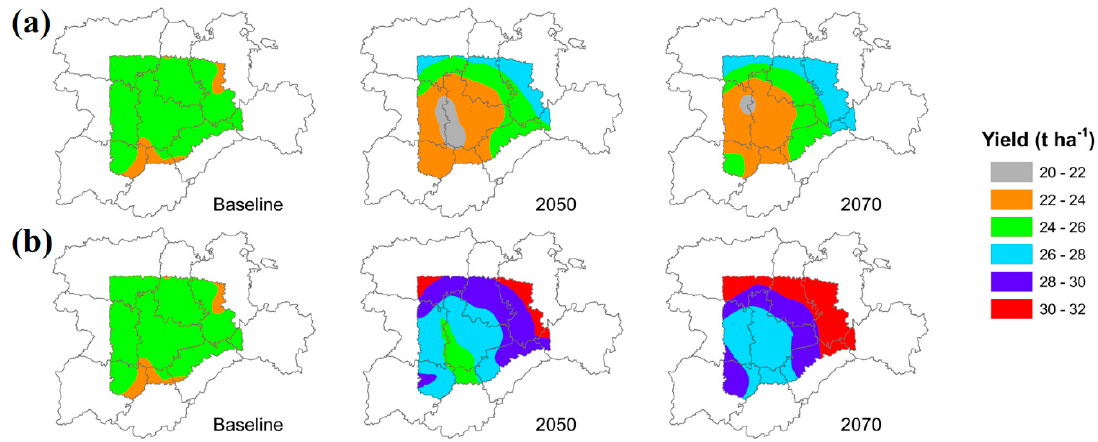
Figure 6. Yield spatial distribution in the area of study in the 2050 and 2070 scenarios vs. the baseline scenario with ( a ) current cultivation period, ( b ) extended cultivation period.